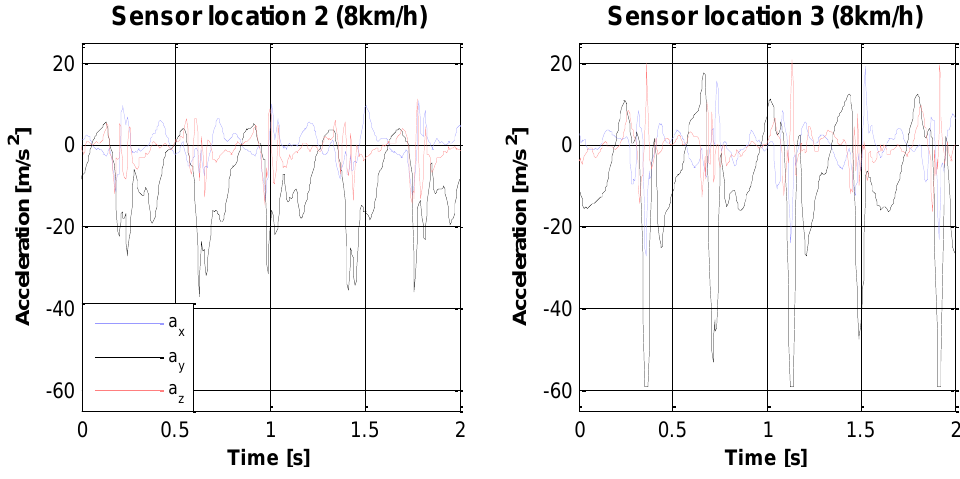
Figure 4. Example of clipping. Example of raw accelerometer data, while jogging 8 km/h. ( Left ), sensor location 2—no clipping. ( Right ), sensor location 3—clipping on one axis at 6 g.